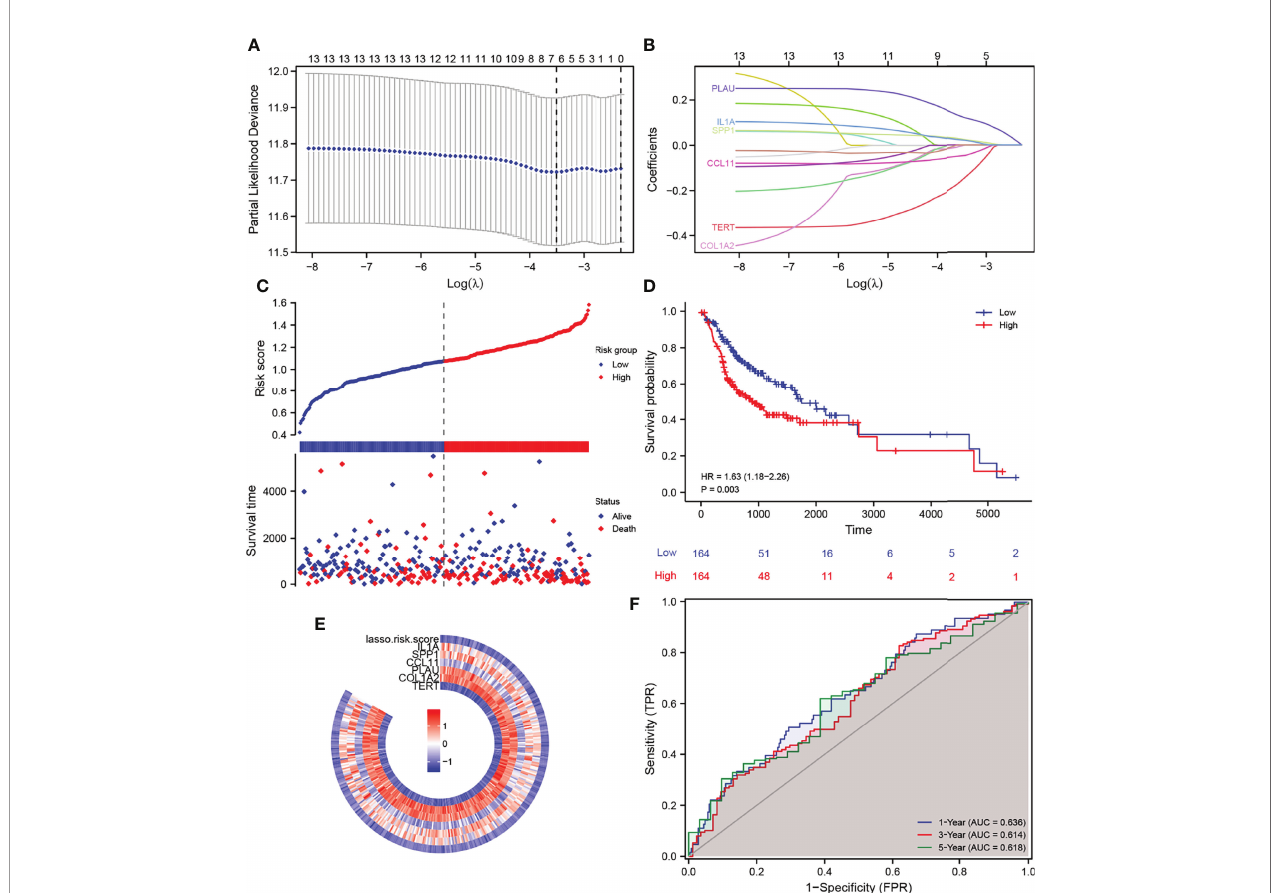
FIGURE 3 | Construction of a prognostic gene signature and its predictive power. (A) LASSO – Cox regression for feature selection to determine optimal parameters. (B) AFOC-DEGs obtained by triple cross-validation of LASSO analysis. (C) Risk factor graph shows the distribution of the risk scores and the correlation between the risk scores and survival data. (D) K-M survival curve shows the difference in survival time between the high-risk group and the low-risk group. (E) Heatmap shows the relationship between the expression levels of AFOC-DEGs and the risk scores. (F) ROC shows the speci fi city and sensitivity of the prognostic model for predicting survival time (1, 3, and 5 years). DEGs, differentially expressed genes; LASSO, least absolute shrinkage and selection operator; K-M, Kaplan – Meier; ROC, receiver operating